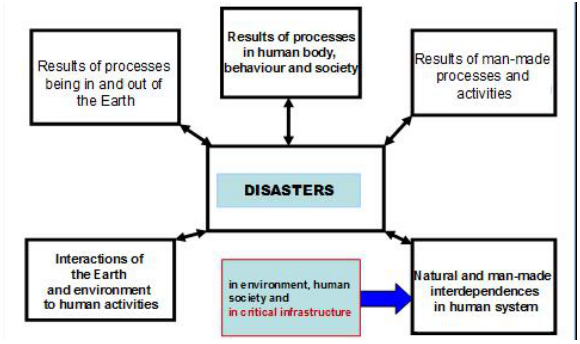
Figure 1. Sources of disasters in the Human sys- tem [3].